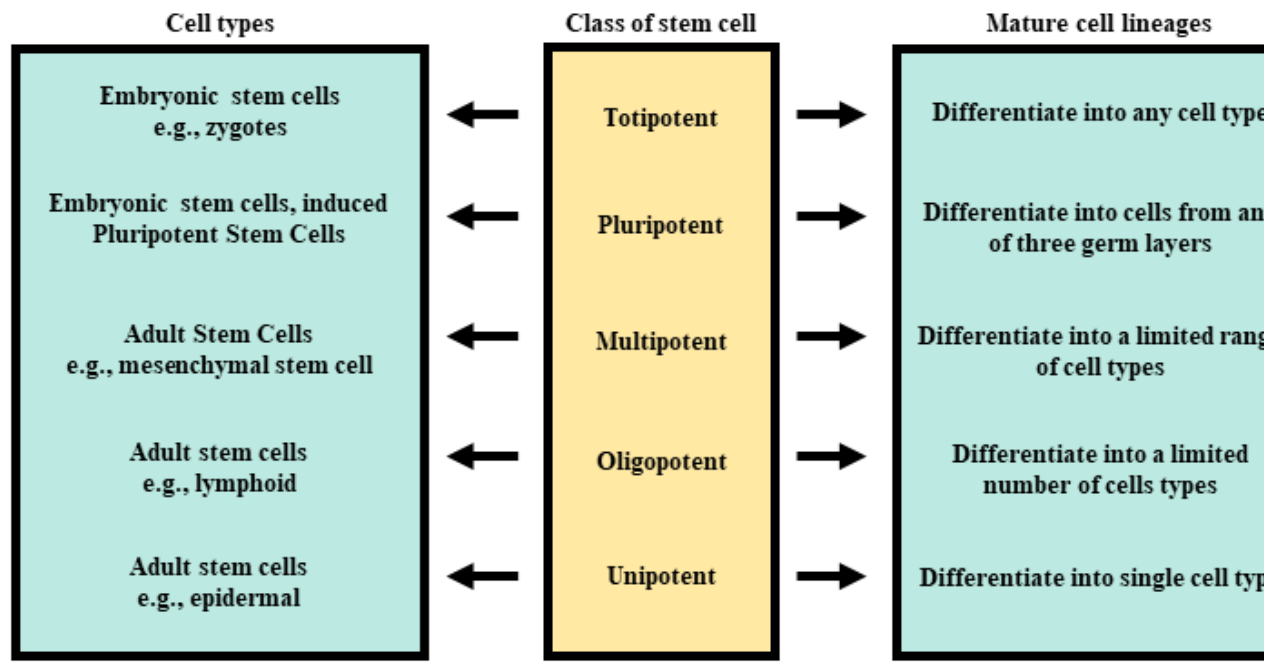
Figure 1. The potential of stem cell differentiation depends on the source of their origin. Another potentially applicable type of stem cells are adult stem cells (ASCs), many of which have roles in postnatal tissue remodeling and repair. Acquiring ASCs does not raise ethical concerns, but as they do not exhibit pluripotency, their applications are limited. However, some studies suggest the expression of pluripotency markers in ASCs, but